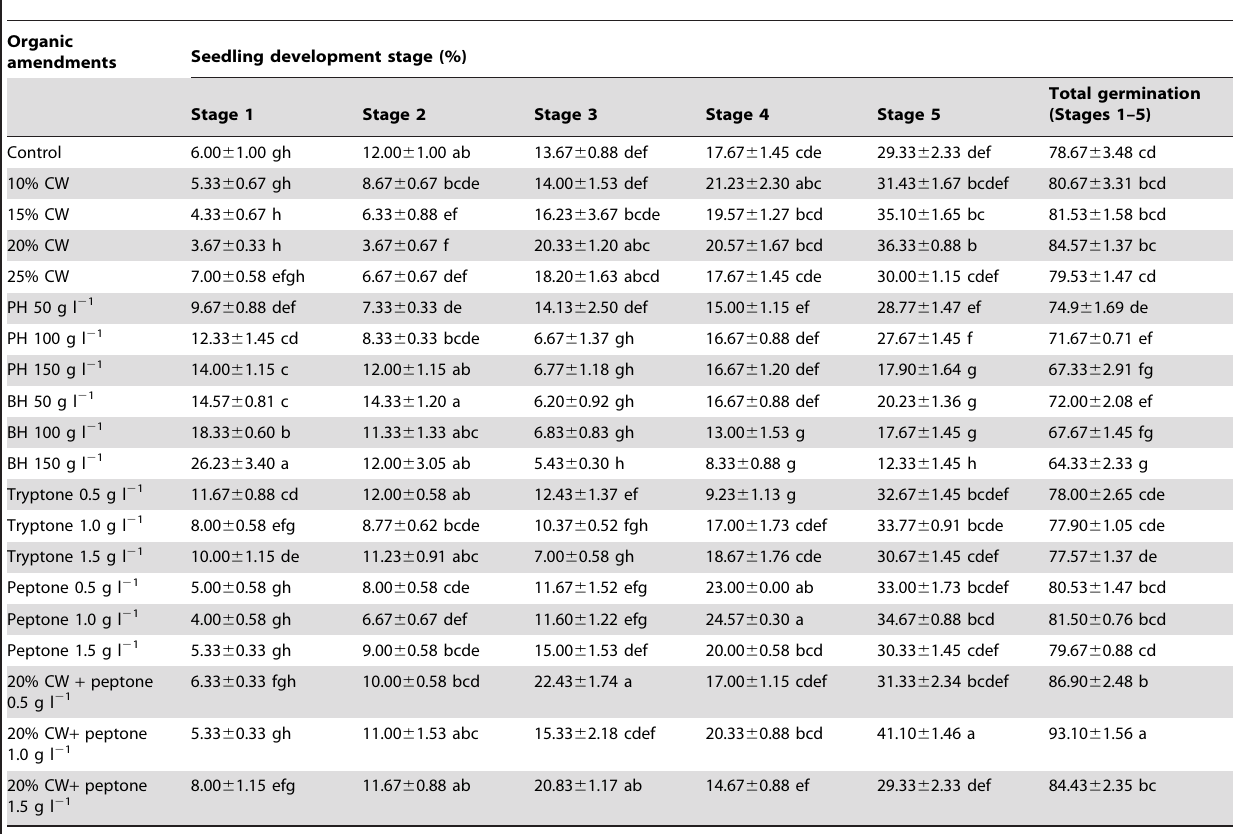
Table 3. Effect of organic amendments on seed germination of Renanthera imschootiana at 150 DAP on 1/4 MS containing